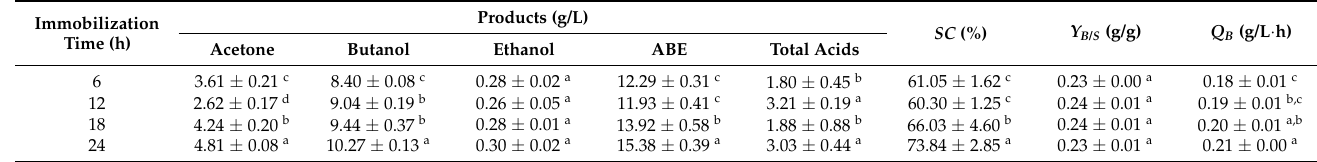
Figure 9. Butanol (black bars) and ABE (gray bars) concentrations of butanol fermentation from SSJ by immobilized cells under various immobilization times. The error bars represent the standard deviation of the mean values. Bars associated with the same letter have no significant differences assessed by Duncan's multiple range test with a critical value of 0.05. Table 8. Butanol fermentation efficiency levels at 48 h with the immobilized cells under different immobilization